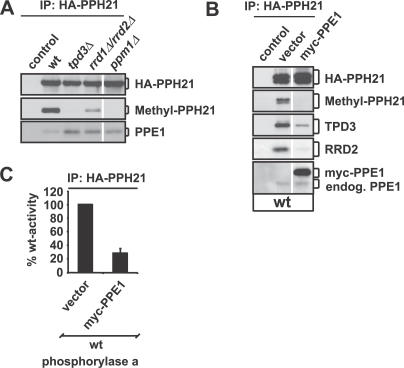
Strains Impaired in C Subunit Biogenesis Display Decreased C Subunit Methylation and Increased PPE1 Binding(A) Anti–HA-tag immunoprecipitates (IP) from lysates of wild-type (wt), tpd3Δ, rrd1Δ/rrd2Δ, and ppm1Δ cells expressing HA-tagged PPH21 were analyzed by SDS-PAGE and immunoblotting. C subunit methylation and the presence of PPE1 were analyzed using specific antibodies.(B and C) HA-PPH21 immunoprecipitates from lysates of wild-type cells expressing HA-tagged PPH21 together with myc-tagged methylesterase (myc-PPE1) (overnight induction under the control of the GAL1 promoter), or containing an empty pYES2 vector (vector), were analyzed by SDS-PAGE/immunoblotting (B) and by phosphatase assays (C) towards phosphorylase a (n = 3). The blots were sequentially incubated with anti-methyl PP2A, anti-RRD2, rabbit polyclonal anti-TPD3, anti-PPE1, and anti-HA antibodies. endog., endogenous.Lanes 4 and 5 (A) and lanes 2 and 3 (B) were not adjacent on the original blot.